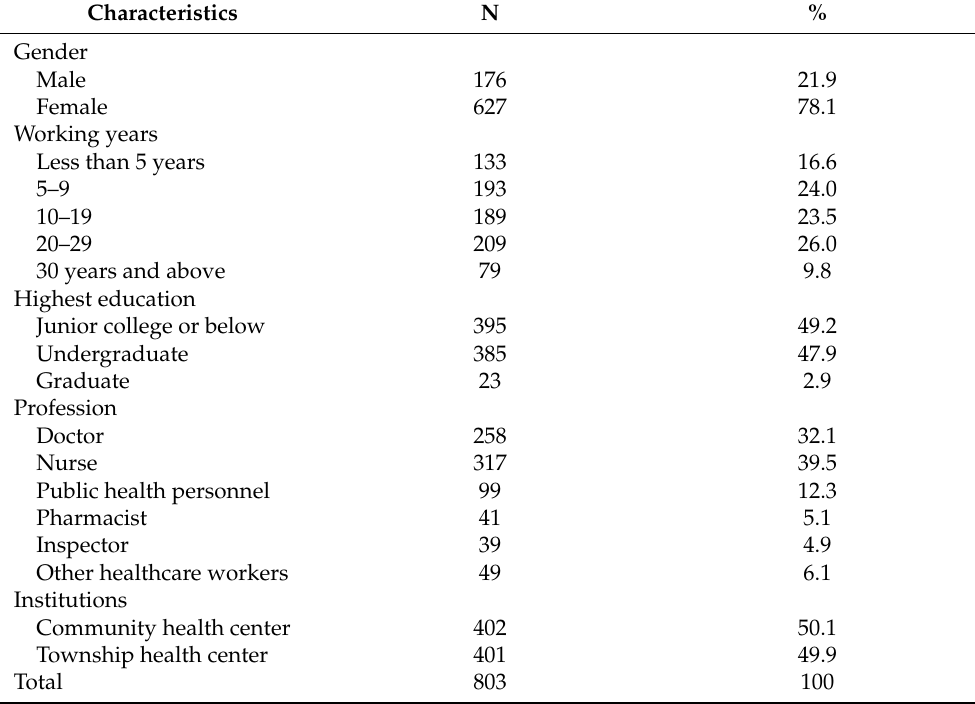
Table 1. Characteristics of the healthcare workers surveyed (N = 803).